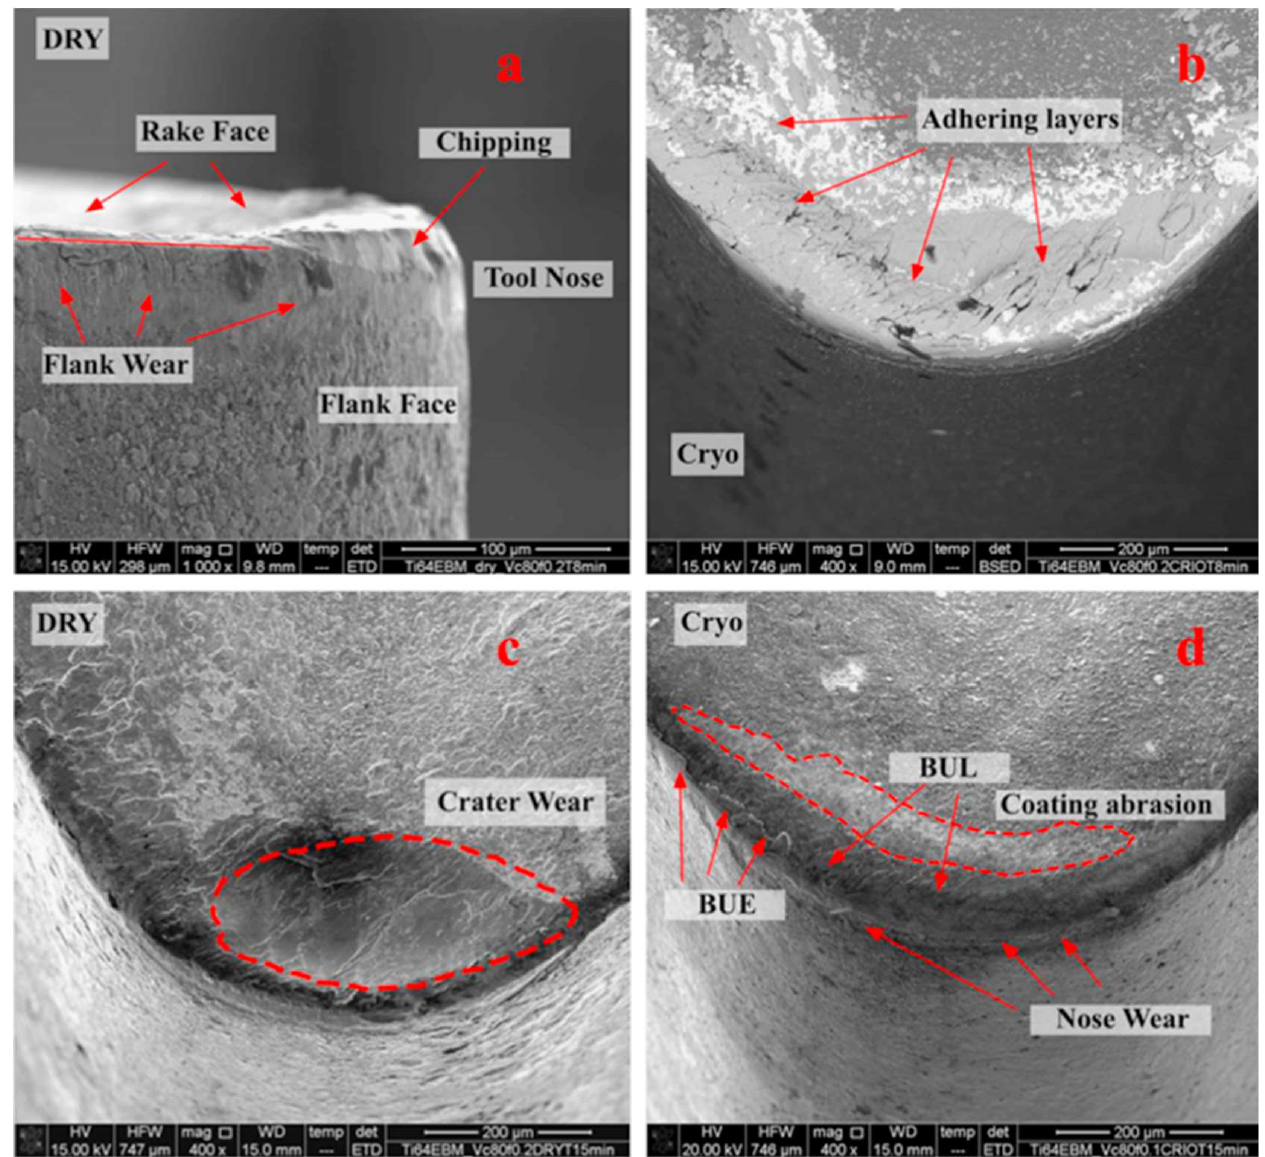
Figure 12. The main tool wear modes observed in dry and cryogenic turning processes: ( a , b ) abrasion, chipping, and adhesion on the flank face and ( c , d ) crater wear, BUE and BUL on the rake face [129] (Reprinted with permission from [129]. Copyright 2015, Elsevier).